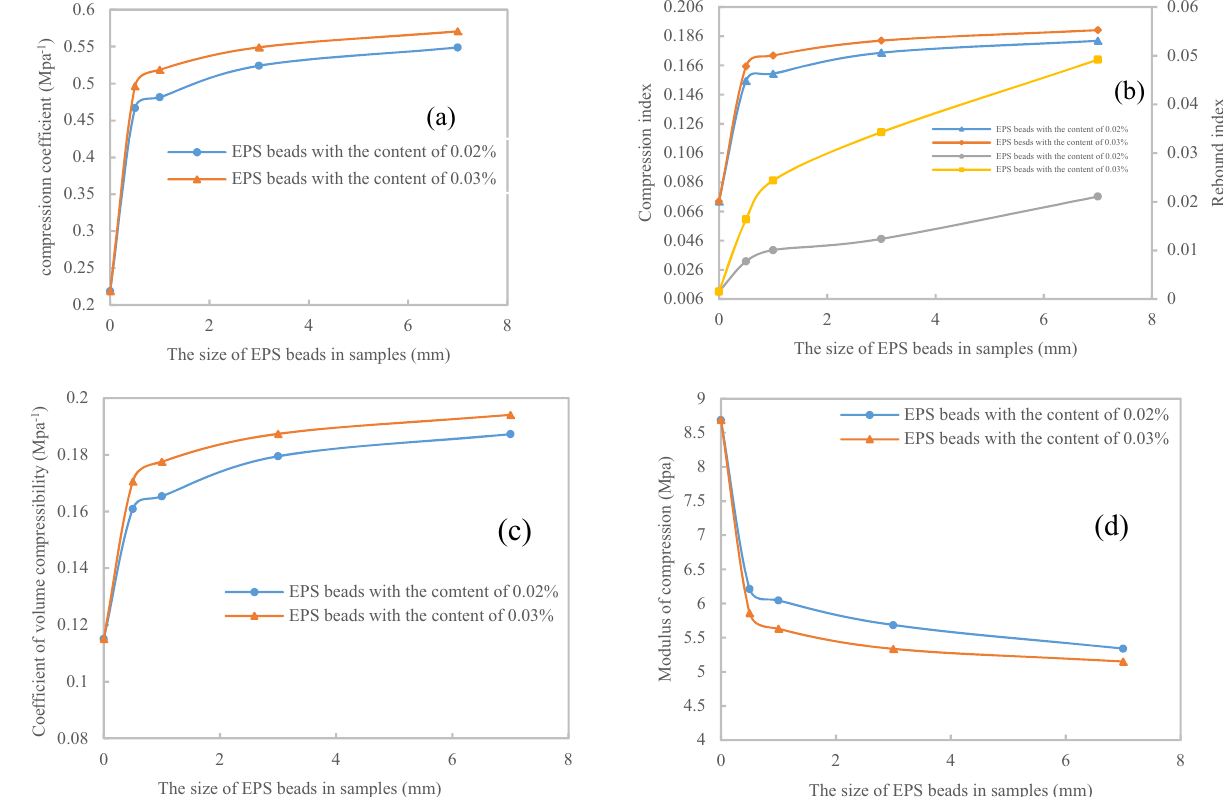
Figure 14: The relationship between the size of EPS beads and the compressibility indexes of soil: ( a ) the relationship between the size of EPS beads and compression coe ffi cient, ( b ) the relationship between the size of EPS beads and compression index and rebound index, ( c ) the relationship between the size of EPS beads and coe ffi cient of volume compressibility, and ( d ) the relationship between the size of EPS beads and modulus of